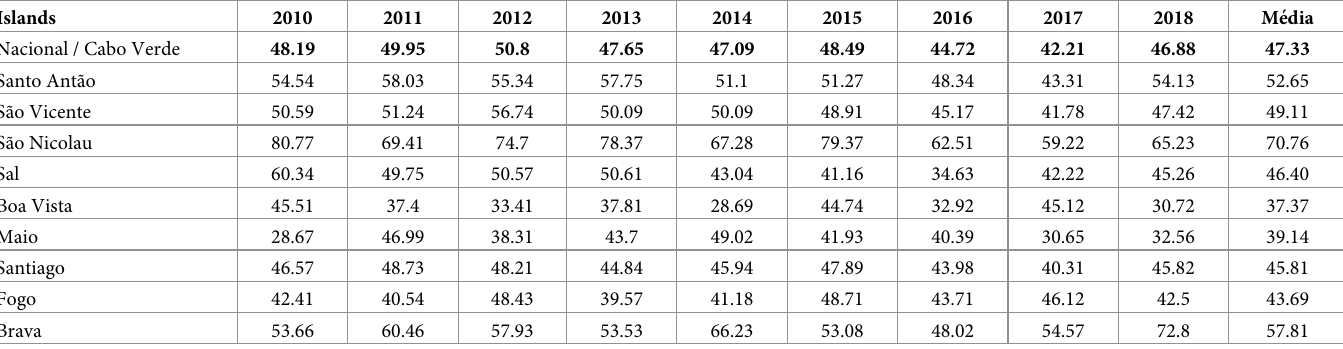
The Table 5 shows the mortality rates in Cabo Verde from 2010 to 2018, the period for comparing mortality between islands. It is noteworthy that there is a positive evolution of mor- tality on the island of Sal (46.4), which had a rate above the national average level (47.33), but it has been decreasing until, as of 2014, it has been below that level. The islands of Boa Vista (37.37), Fogo (43.69), Maio (39.14), Santiago (45.81) and Sal (46.4) have an average rate lower than the national level (47.33), while for the islands of S ã o Nicolau (70.76), Brava (57.81), Santo Ant ã o (52.65) and S ã o Vicente (49.11) the opposite happens, the average is higher than the national one (47.33). However, from 2015 onwards, the mortality rate on the island of S ã o Vicente shows a converging trend towards the national level. Table 5. Total mortality rate (per 10 thousand) per island (2010–2018).